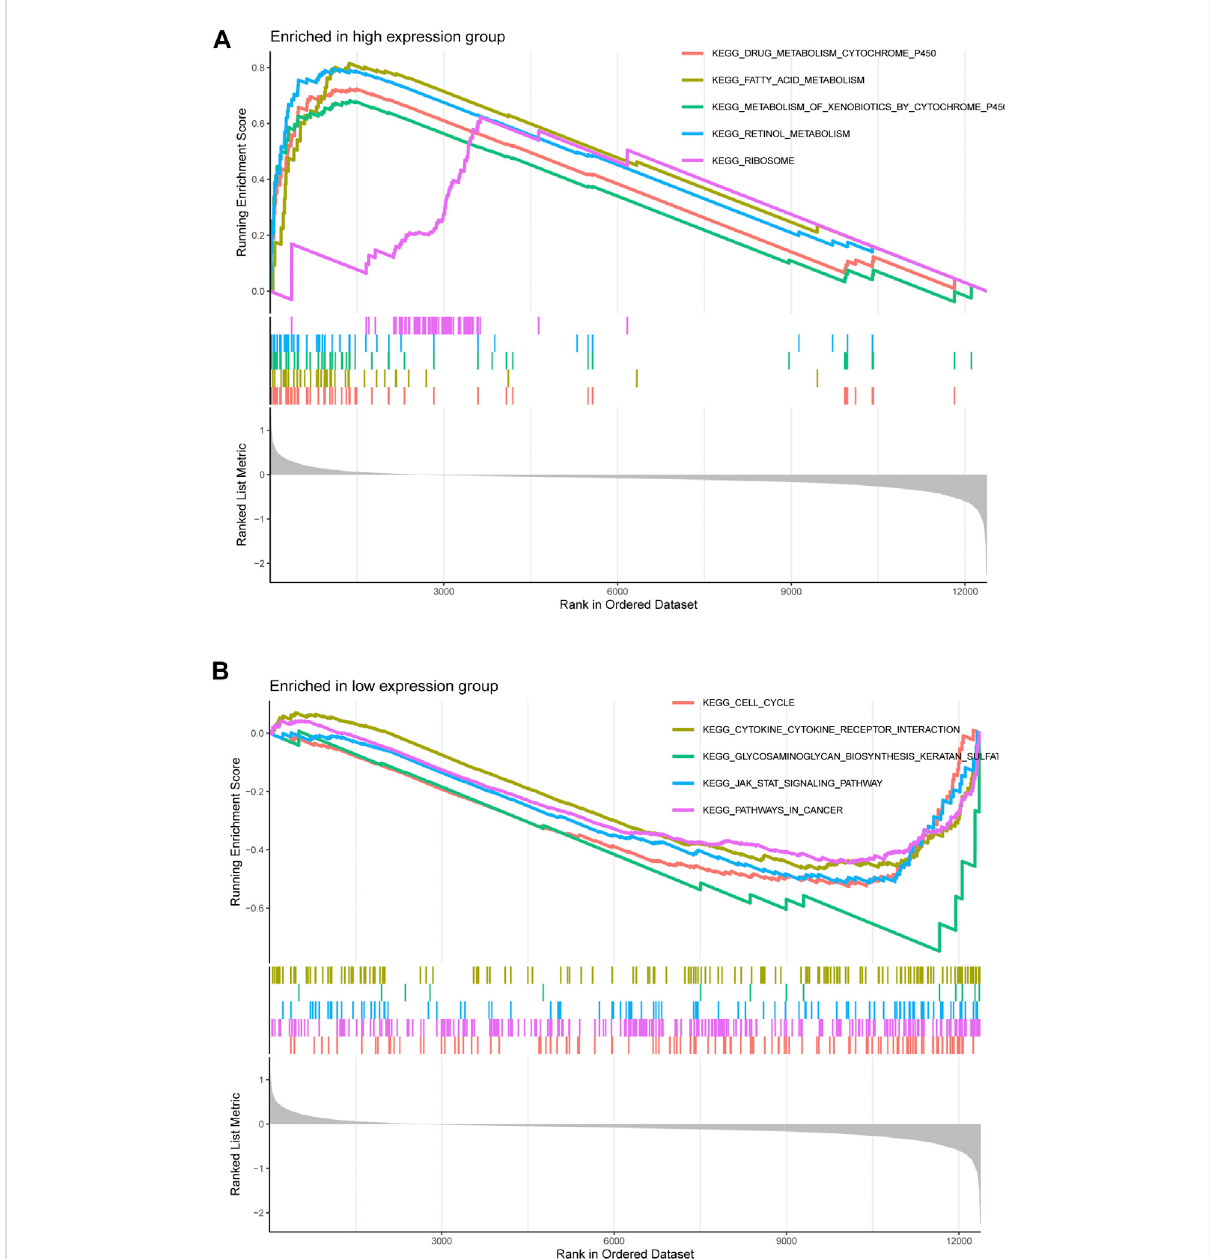
FIGURE 6 Gene Set Enrichment Analysisof LECT2 in HCC. (A) The fi vepathwayswere most signi fi cantly enrichedin theLECT2 high-expression group (B) The fi ve pathways were most signi fi cantly enriched in the LECT2 low-expression